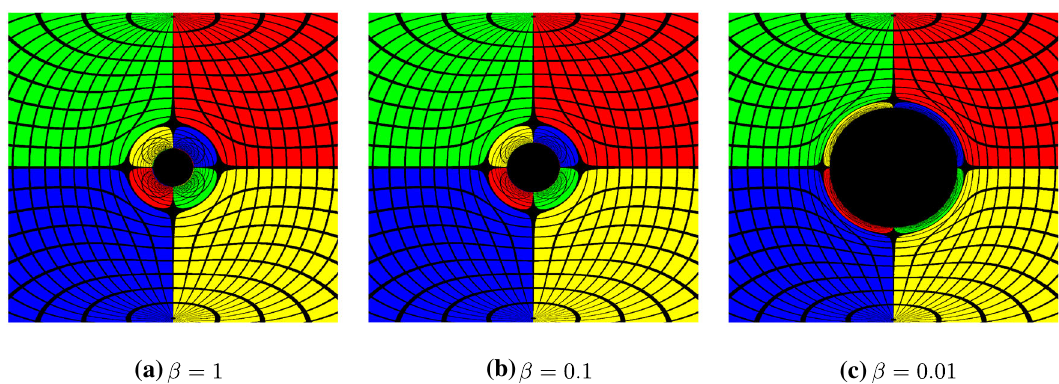
Fig. 2 Images of magnetically charged BI black holes with m = 1 and P = 0 . 8 for β = 1, β = 0 . 1 and β = 0 . 01 respectively. We find that the shadow radius increases with the decrease of β Fig. 3 The shadow radius r sh in a and the photon sphere radius divided by the horizon radius r ph / r h in b with respect to the BI parameter β for magnetically charged BI black holes for different P with m = 1. When β = β c , the radius of the shadow remains unchanged regardless of the value of P . While the decrease of β or the increase of P makes r ph / r h increase